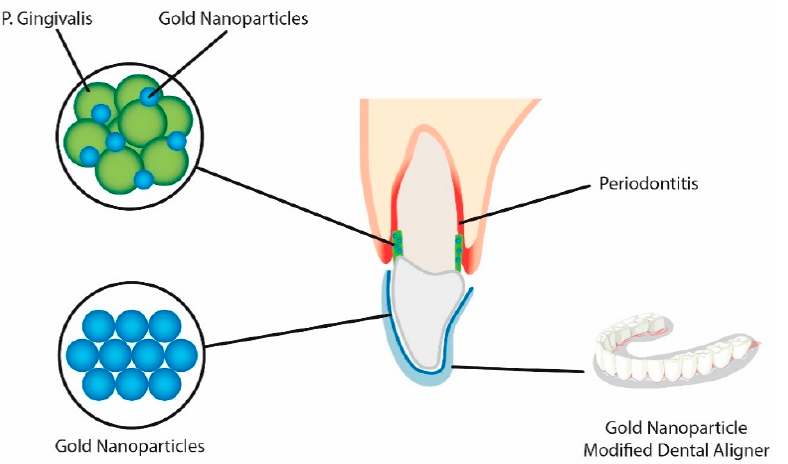
Figure 1. Aligners coated with modified gold nanoparticles causing enhanced antibacterial activity against Porphyromonas gingivalis . Due to presence of the coated aligner, the number of bacterial cells was decreased, causing increased biofilm formation prevention.